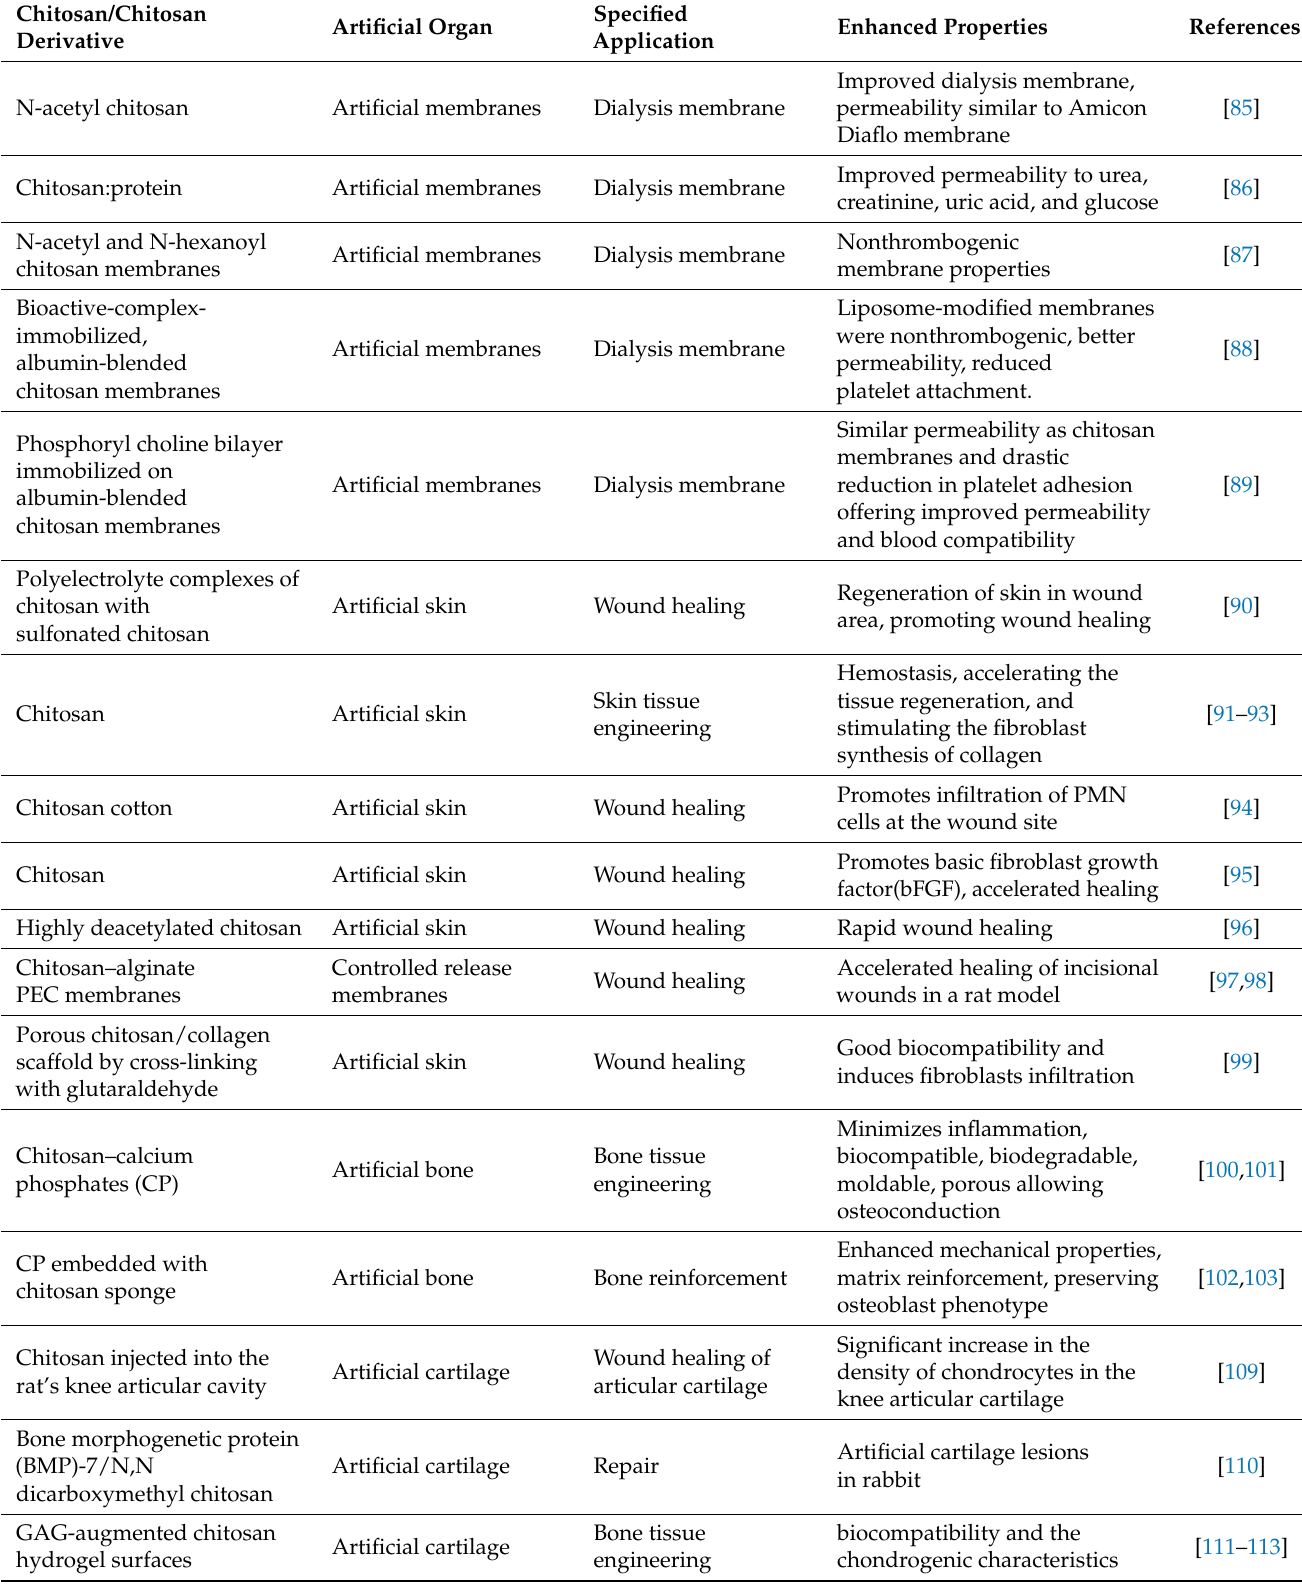
Table 1. Summary of applications of chitosan and composites towards artificial